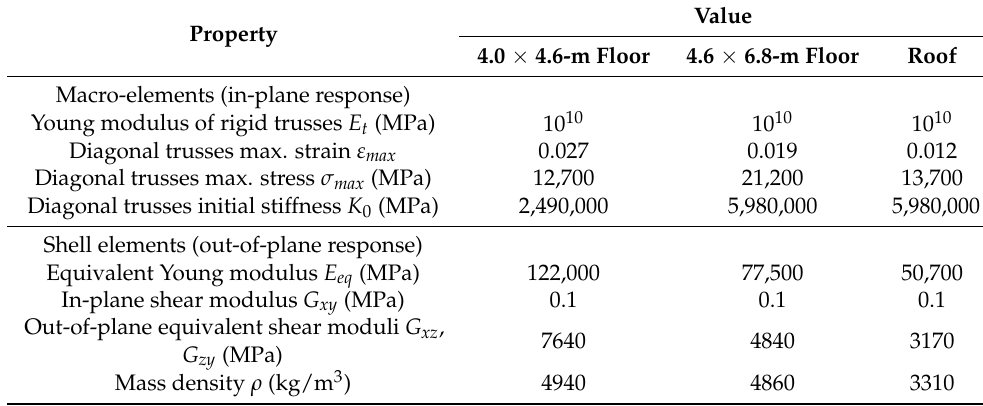
Table 4. Properties of the shell elements (thickness = 36 mm) and macro-elements representing the diaphragms retrofitted with plywood panels in configuration B1-PP. Reprinted from Reference [41].